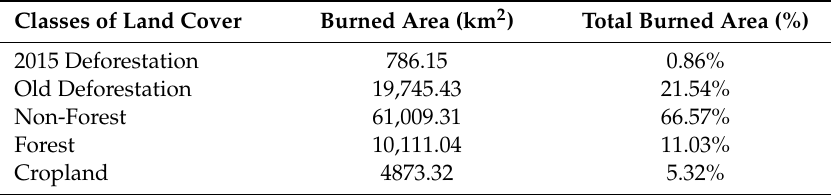
Table 2. Estimated burned areas in deforested areas, forest, non-forest, and cropland areas using the final composite